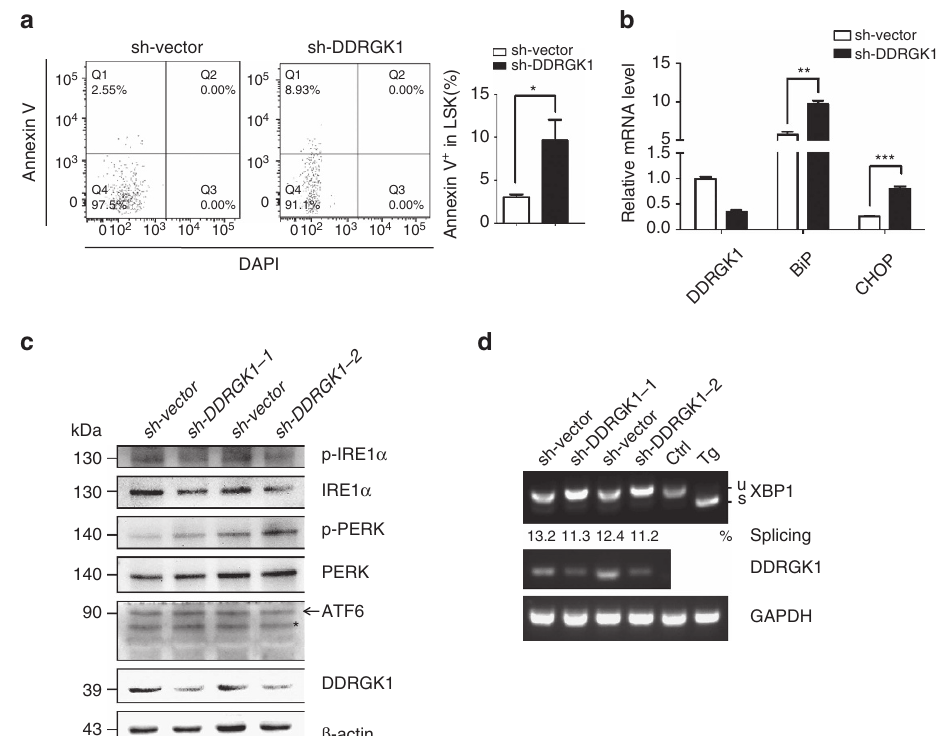
Figure 8 | Knockdown of DDRGK1 induces ER stress in HSCs. ( a ) Representative FACS pattern showing the percentage of Annexin V-positive cells within the donor-derived control and DDRGK1-knockdown LSK cells after transplantation (Left panel). Bar graph shows the percentage of Annexin V-positive cells within LSK cells (Right panel, n ¼ 3). Data are presented as mean ± s.d. * P o 0.05 by Student’s t -test. ( b ) Q-PCR analysis of the relative mRNA expression levels of DDRGK1 , BiP and CHOP in donor-derived control and DDRGK1-knockdown LSK cells after transplantation ( n ¼ 3). Data are presented as mean ± s.d.